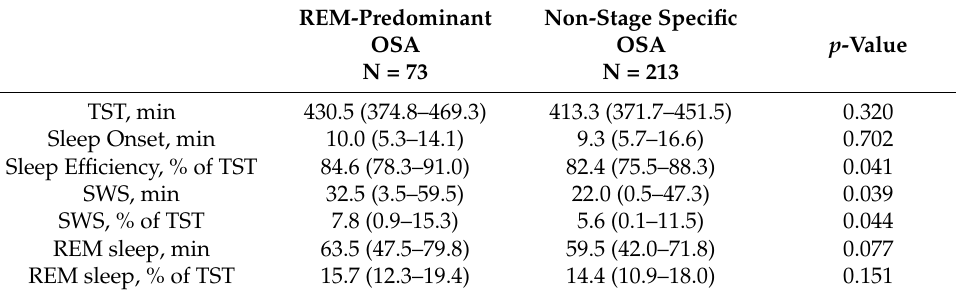
Table 2. Polysomnographic findings of the study population ( n =